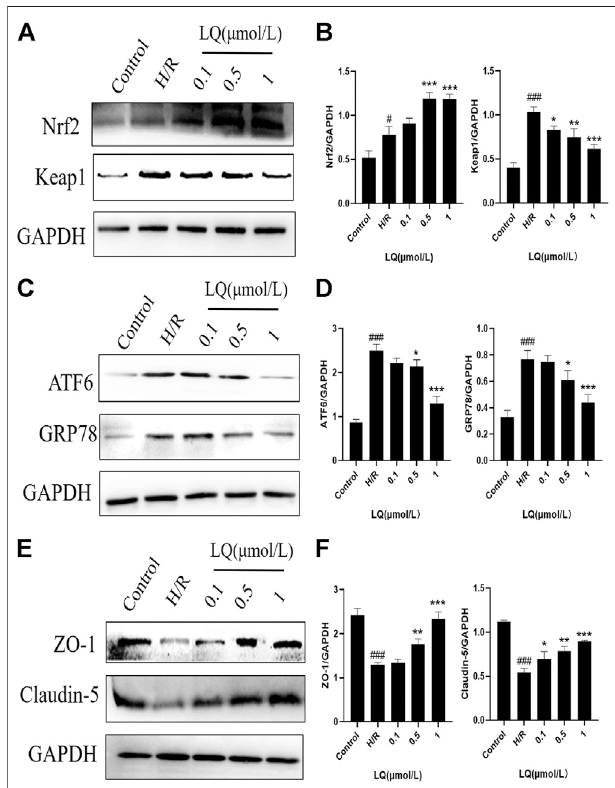
FIGURE 6 | LQ regulations oxidative stress and ER stress pathway proteins and maintains BBB integrity. (A, B) The oxidative stress pathway proteinsKeap1and Nrf2weredetected byWesternblot. (C,D) TheERstress pathway proteins ATF6 and GRP78 were detected by Western blot. (E, F) The BBB relative proteins ZO-1 and Claudin-5 were analyzed by Western blot. # p < 0.05, ### p < 0.001, compared to control. * p < 0.05, ** p < 0.01, *** p < 0.001, compared to